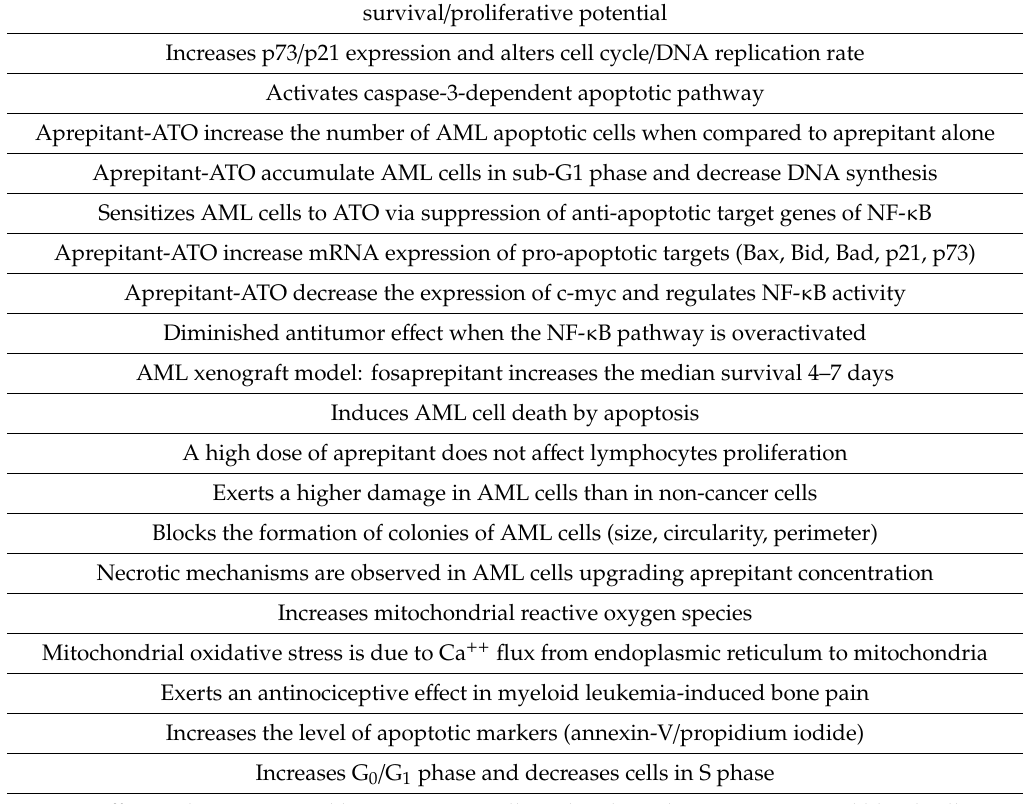
Table 2. E ff ects of aprepitant in AML